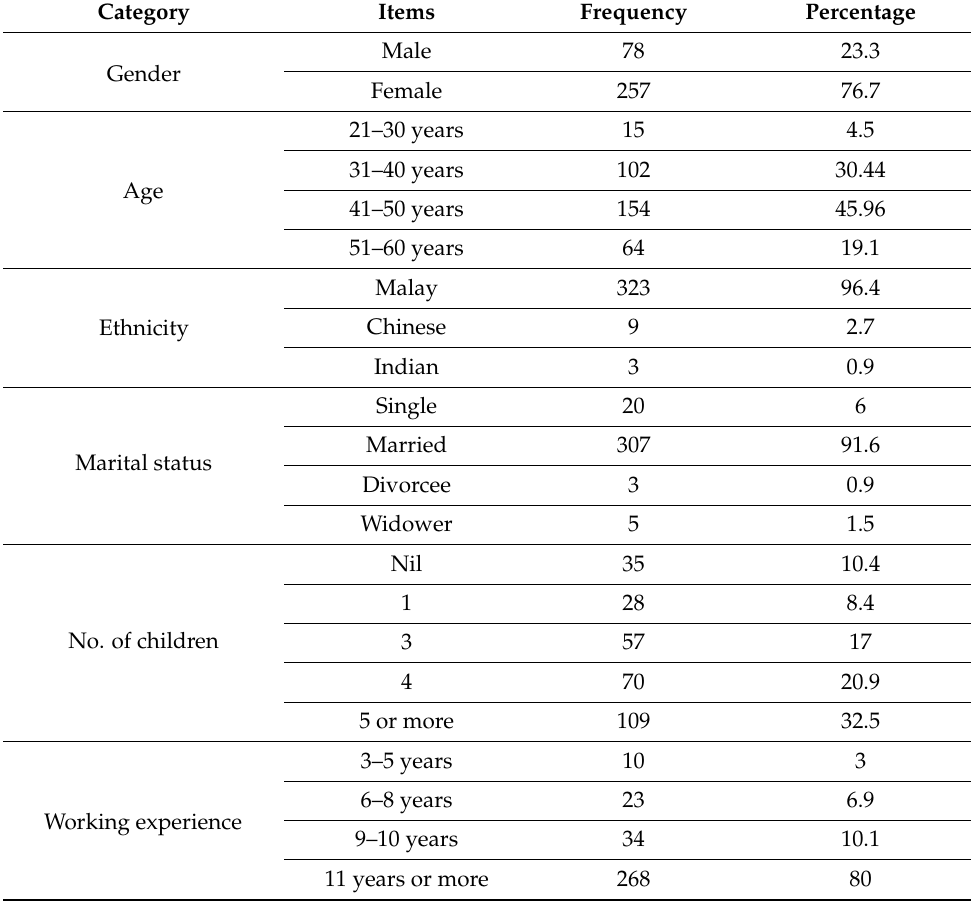
Table 1. Respondent’s